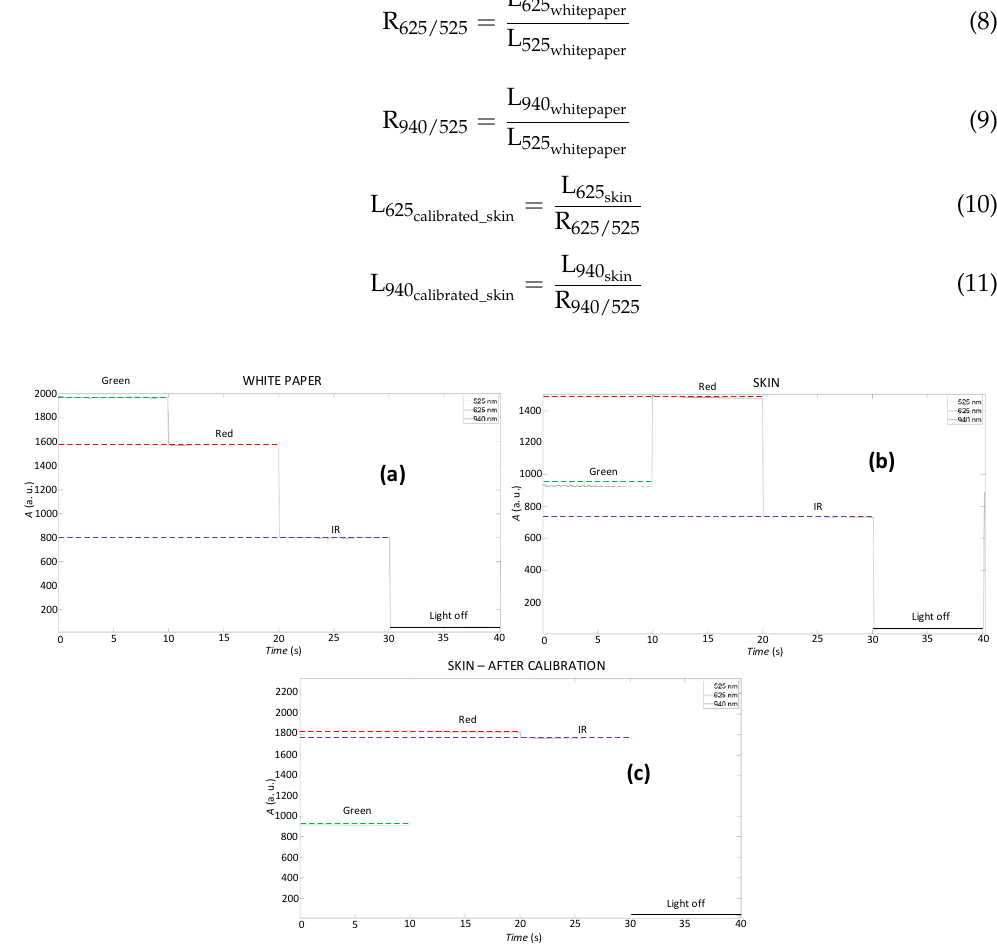
Figure 19. Software calibration process: ( a ) magnitude of signals observed from white paper; ( b ) magnitude of signals observed from skin; ( c ) magnitude of signals observed from skin after calibration process.